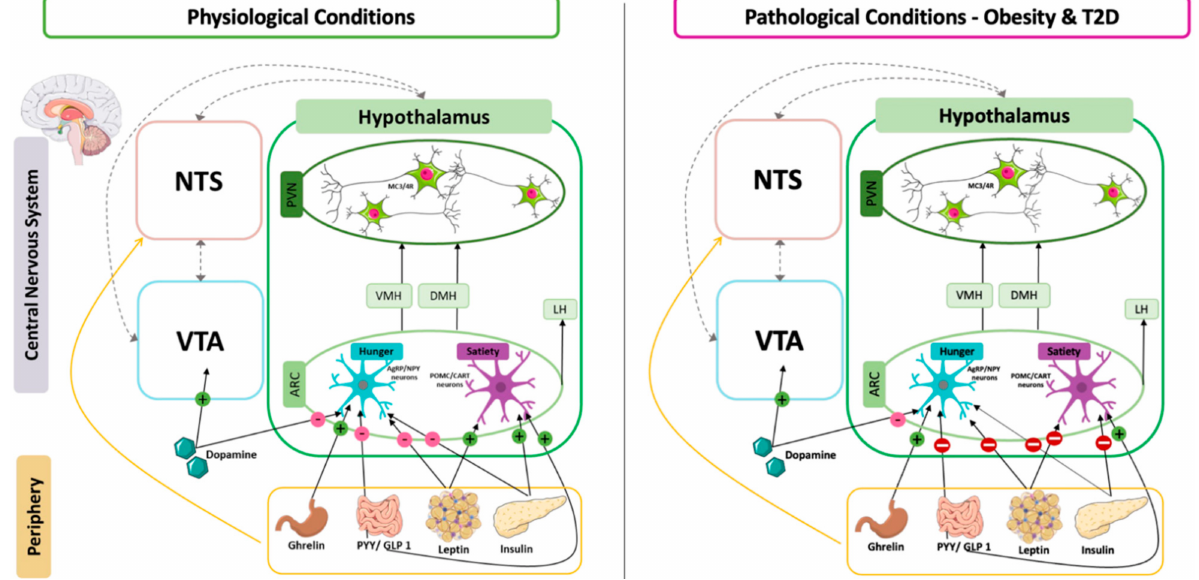
Figure 1. Schematic representation of the brain’s satiety network. The left panel shows the neu- rochemistry and brain network involved in the physiological regulation of feeding behaviour and energy homeostasis and the right panel shows the same network and neurochemistry in pathological conditions, such as obesity and type 2 diabetes. Peripheral signals, such as ghrelin, PYY, GLP1, leptin, and insulin, act in certain regions of the CNS, namely the NTS, hypothalamus, and VTA. Within the hypothalamus, specifically in the ARC nucleus, the satiety-related POMC/CART neurons are acti- vated by insulin, leptin, and GLP 1, and the hunger-related AgRP/NPY neurons are inhibited by PYY, leptin, and dopamine, and activated by ghrelin. Neuronal activity modulation of the ARC nucleus by these peripheral signals will promote alterations in other nuclei of the hypothalamus. In pathological conditions, such as obesity and type 2 diabetes, many of the peripheral signals that modulate ARC nucleus neuronal activity are impaired, with the main relevance for the blocking of insulin,